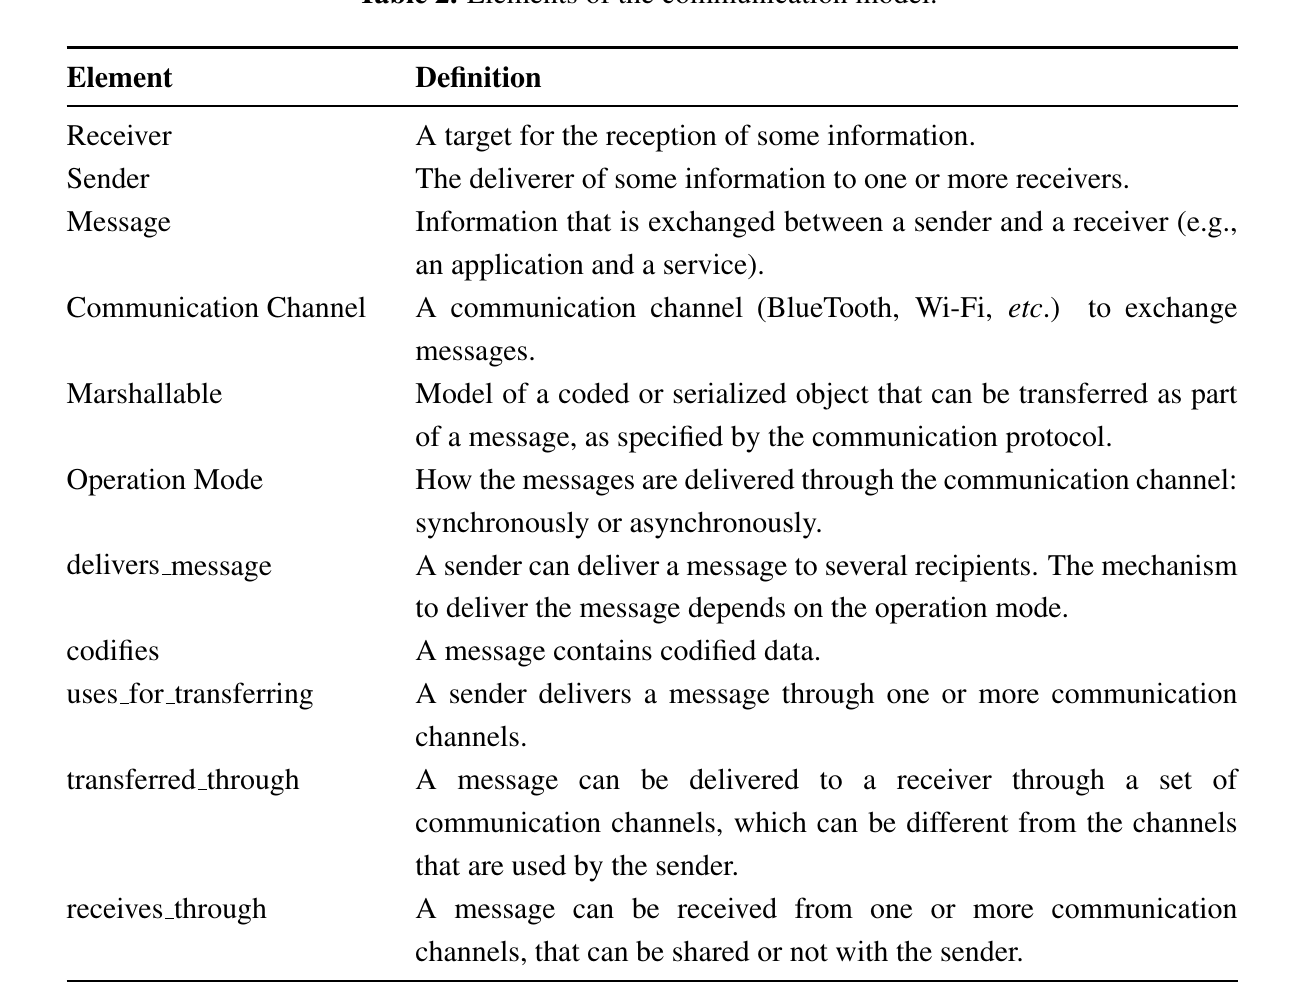
Table 2. Elements of the communication